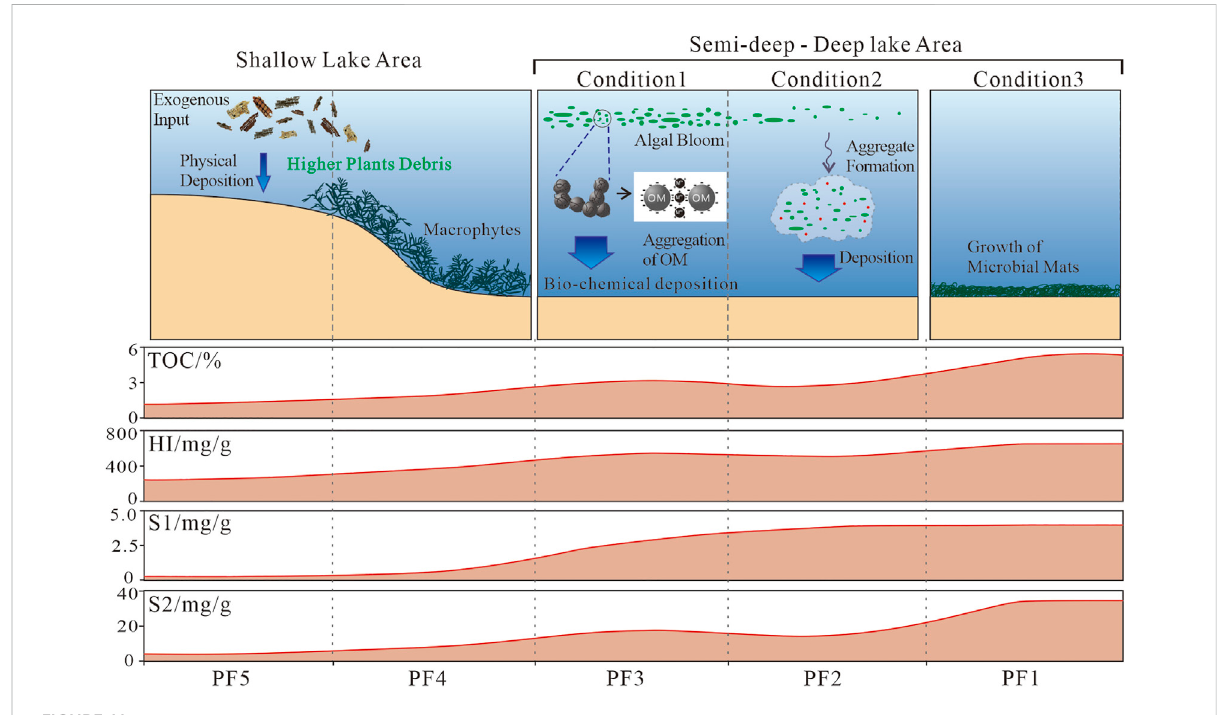
FIGURE 11 Sedimentary model and hydrocarbon generation parameters of